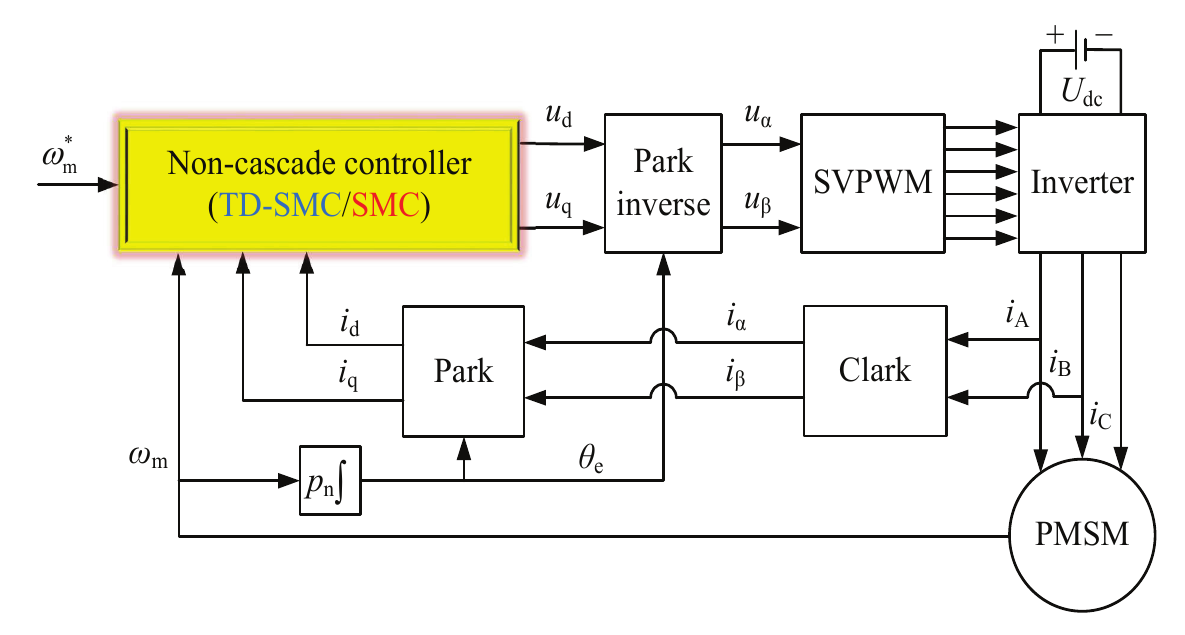
Figure 2. The whole block control structure for a PMSM servo system.